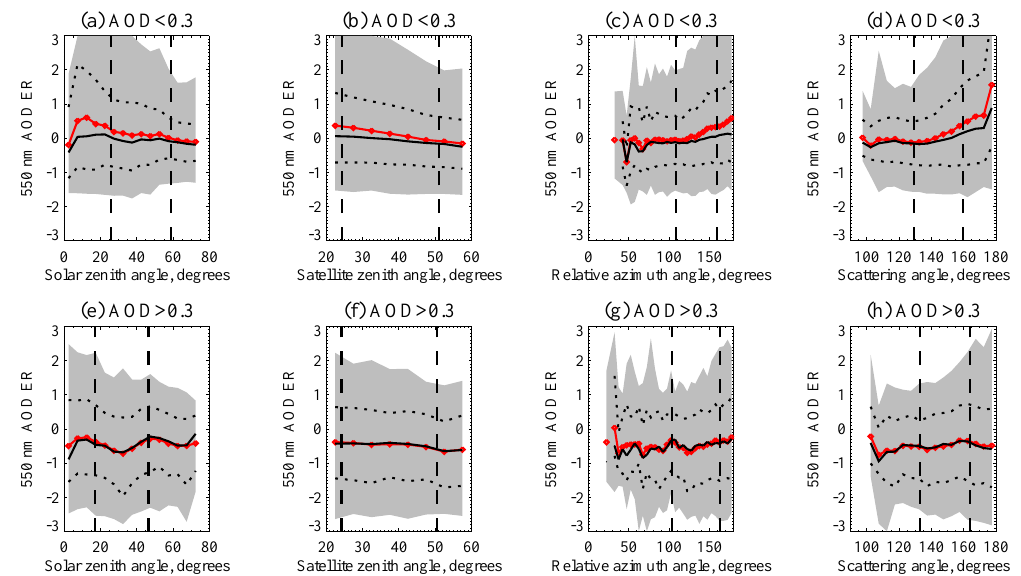
Fig. 6. Retrieval error ratio (ER) at 550nm, defined as the ratio of the retrieval error to the expected error, as a function of retrieval geometry. The top row shows points where τ A,550 < 0.3, and the bottom row τ A,550 > 0.3. Plots show dependence on (a, e) the solar zenith angle, (b, f) satellite (viewing) zenith angle, (c, g) relative azimuth angle, and (d, h) scattering angle. The bin size is 5 ◦ for each angle, and only bins with 5 or more points are shown. The lines and symbols are as indicated in Fig. 4. Dashed vertical lines show the angular range in which the central 68% of the data lie. Only points where QA=3 are